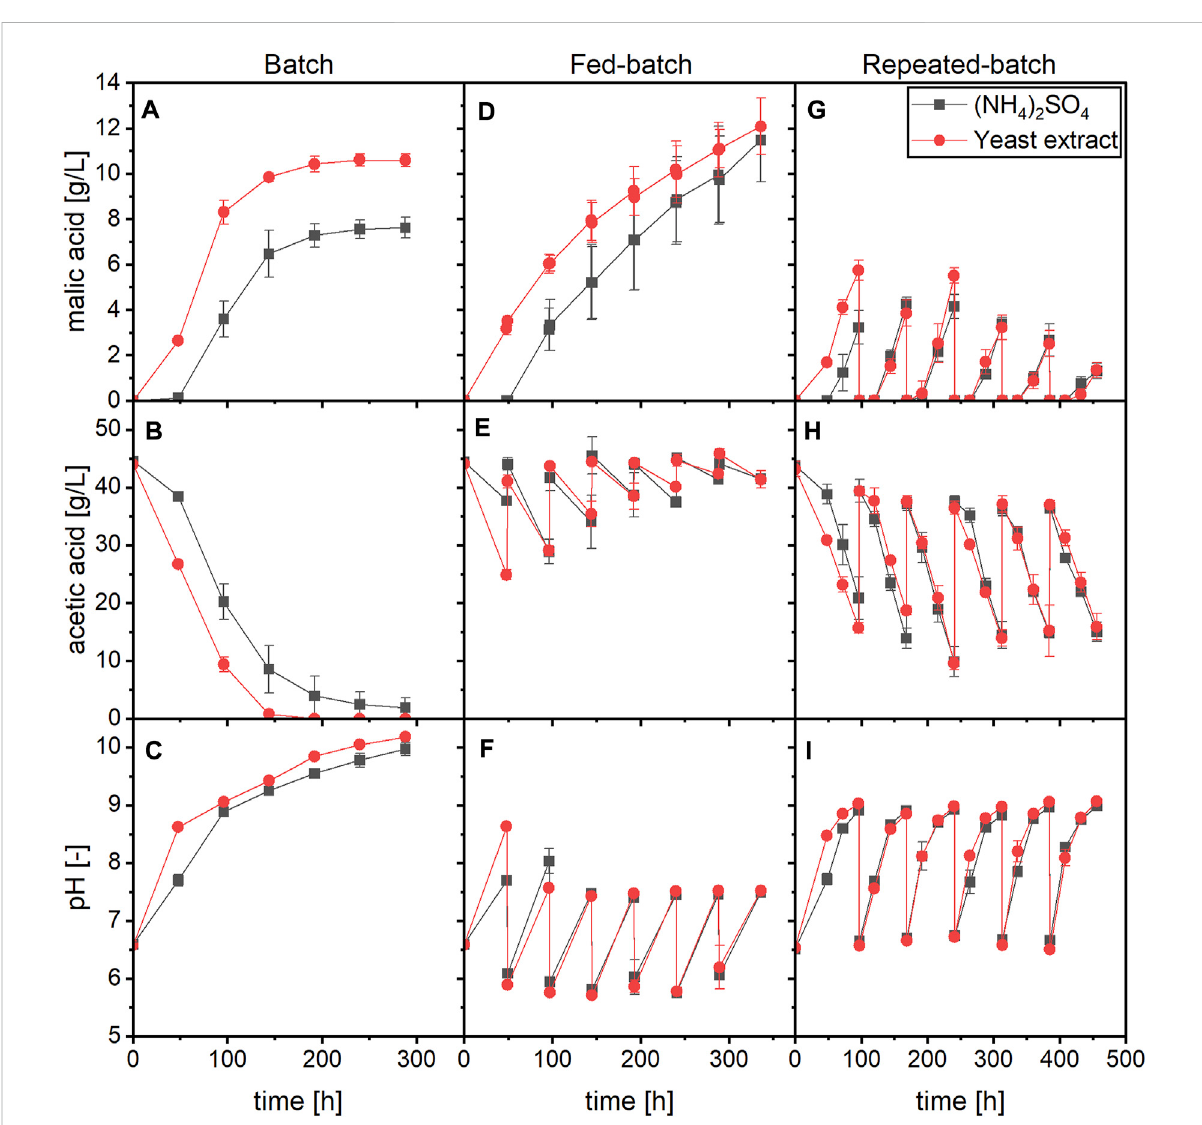
FIGURE 4 Time course of malic acid production, substrate consumption and pH for a batch (A – C) , fed-batch (D – F) and repeated-batch (G – I) process with A. oryzae using